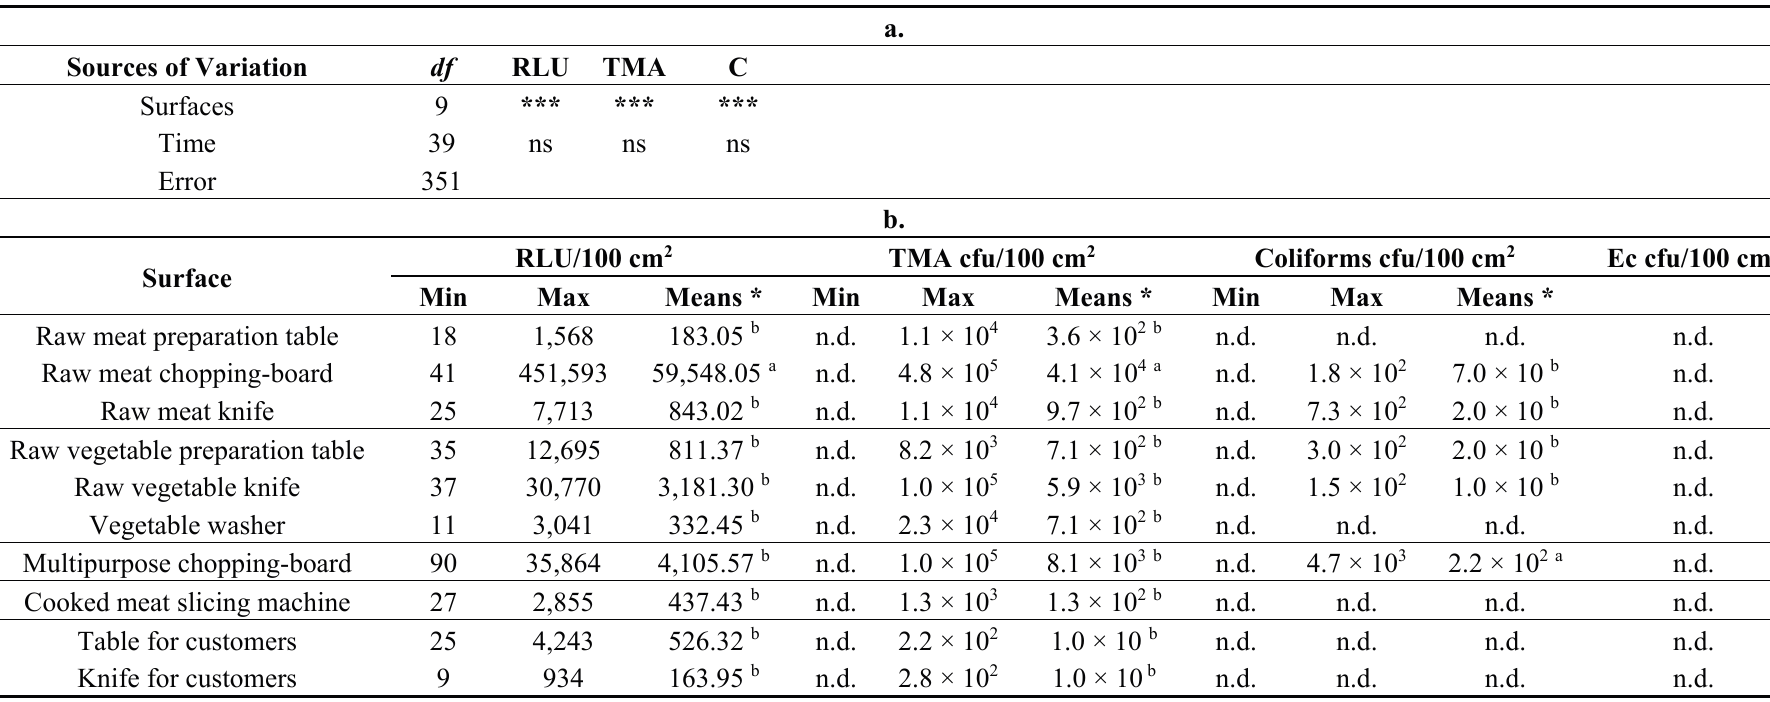
Table 3. ANOVA results ( a ) and multiple comparisons among mean values and range of data variation (minimum and maximum values) for each surfaces and variables analyzed ( b ) after routine cleaning and sanitation of food contact surfaces.